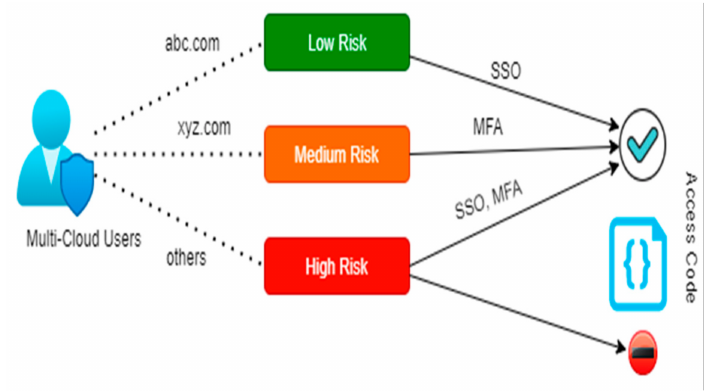
Figure 1. Risk level assessment and proposed mitigation